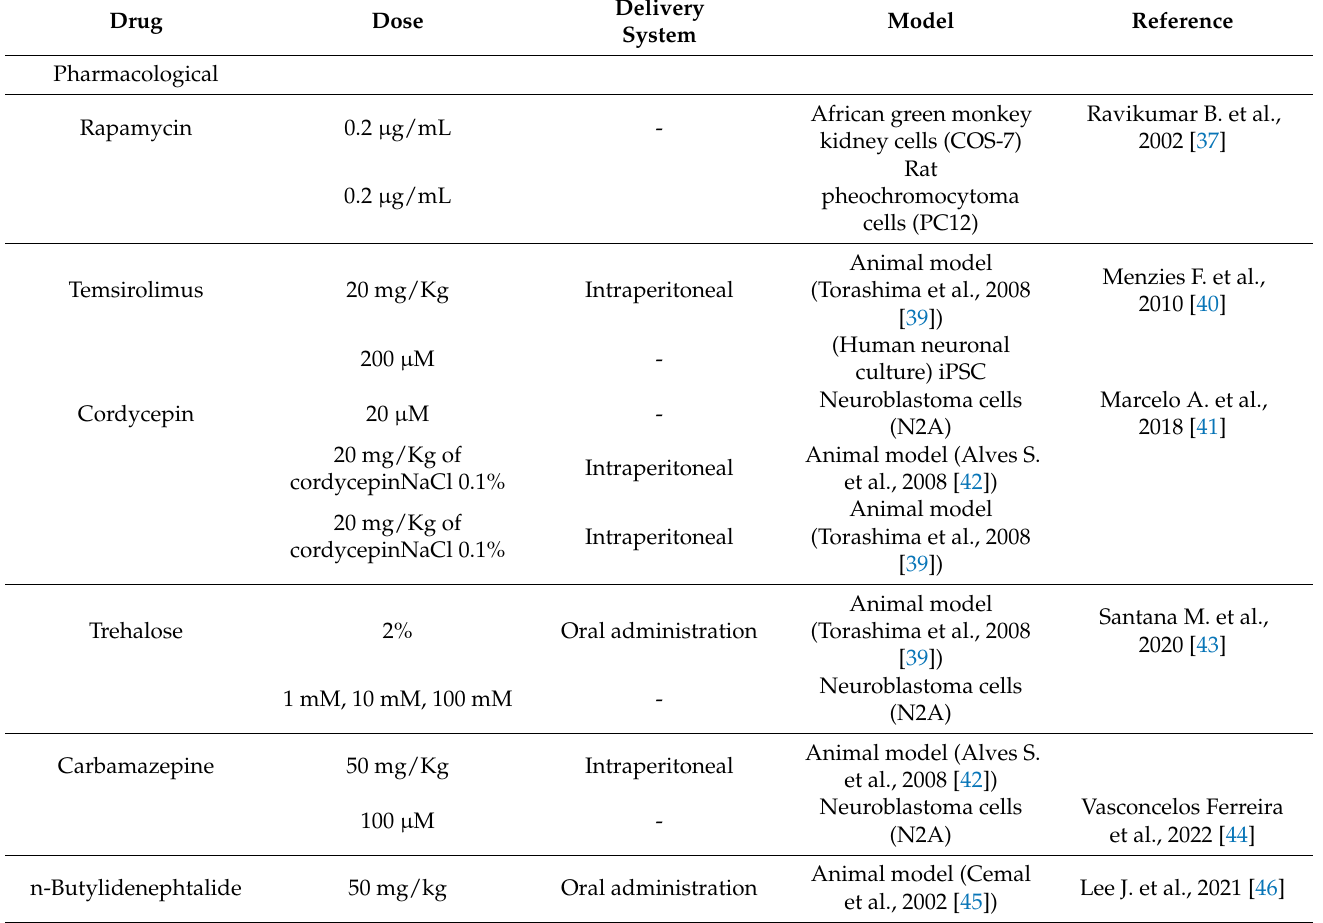
Table 2. Overview of selected studies using pharmacological compounds to activate autophagy as a therapeutic strategy for